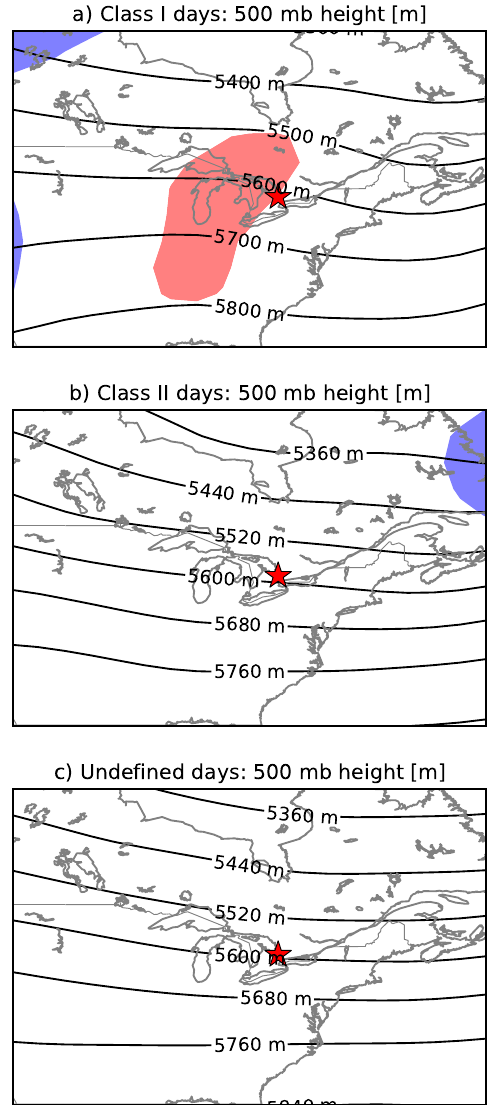
Figure 6. NCEP reanalysis mean 500mb geopotential heights (m) for (a) class I, (b) II, and (c) undefined days. Positive 95% signifi- cance anomalies are shaded in pink and negative 95% significance anomalies are shaded in